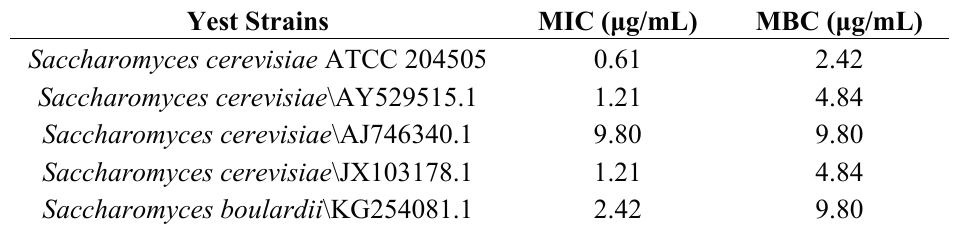
Table 3. MIC a and MBC b of clematoside-S (2) for different yeast